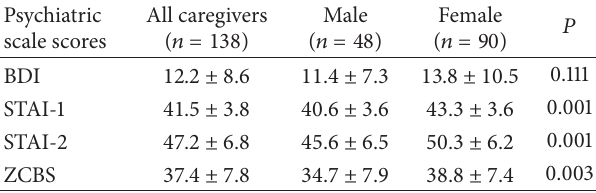
Table 2: Comparison of the psychiatric scale scores of caregivers according to